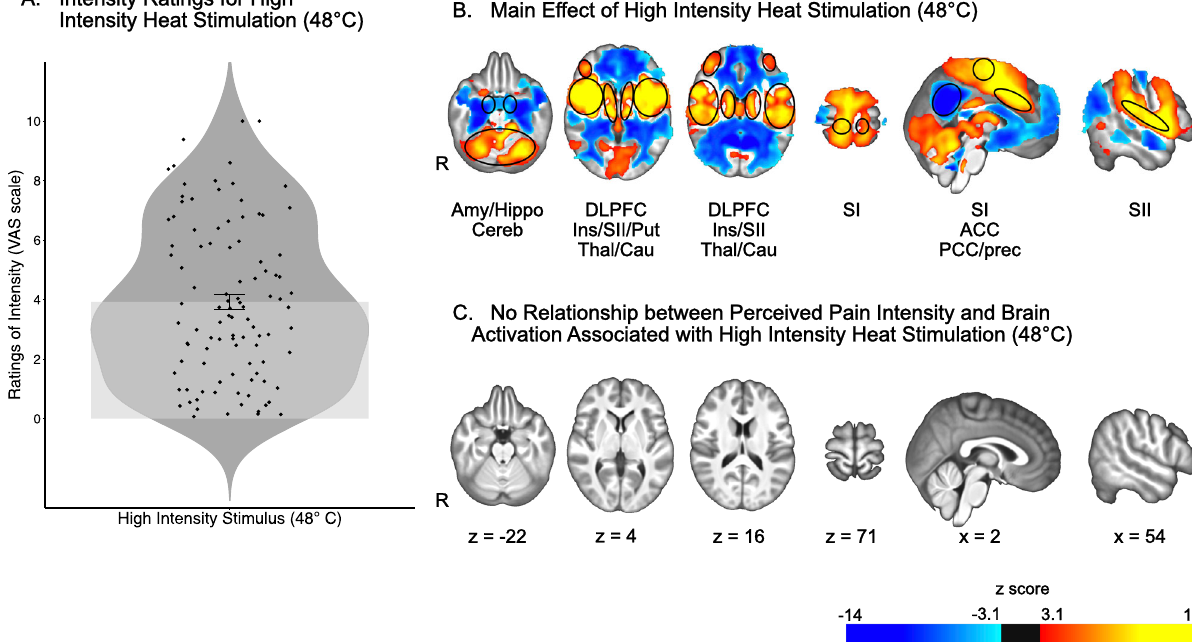
Fig. 2 Univariate fMRI analysis reveals widespread brain activation associated with high intensity heat stimulation, but no relationship with perceived pain intensity. A Individual ratings of pain intensity in response to high intensity heat stimulation ranged from 0.07 to 10, with most people providing averaged ratings of pain intensity below 5. Mean and standard error represented by the bar plot. n = 101 participants. B Effect of high intensity heat stimulation on brain activation. Areas of increased activation included cerebellum (Cereb), thalamus (Thal), putamen (Put), primary somatosensory cortex (SI), secondary somatosensory cortex (SII), insula (Ins), anterior cingulate cortex (ACC), and dorsolateral prefrontal cortex (DLPFC). Areas of decreased activation included the amygdala (Amy) and hippocampus (Hippo), as well as posterior cingulate cortex (PCC) and precuneus (Prec). C There was no relationship between perceived pain intensity and brain activation associated with high intensity heat stimulus. Source data are provided as an xlsx Source Data fi le and activation maps are available on